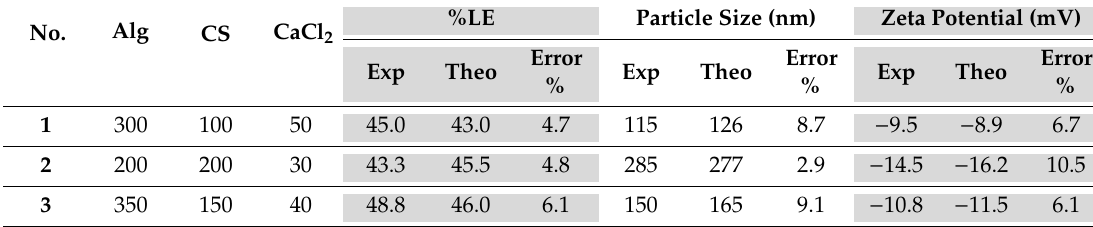
Table 6. Response optimization for LE, particle size and zeta potential.